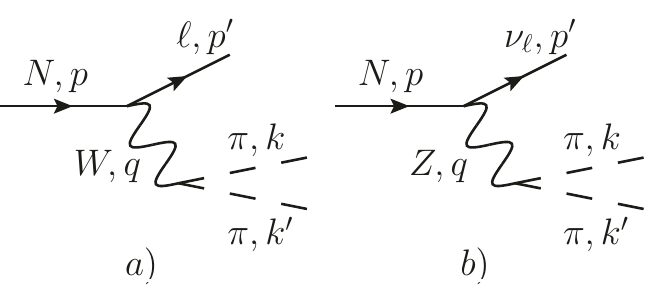
Figure 20 . Diagram for the HNL decay into 2